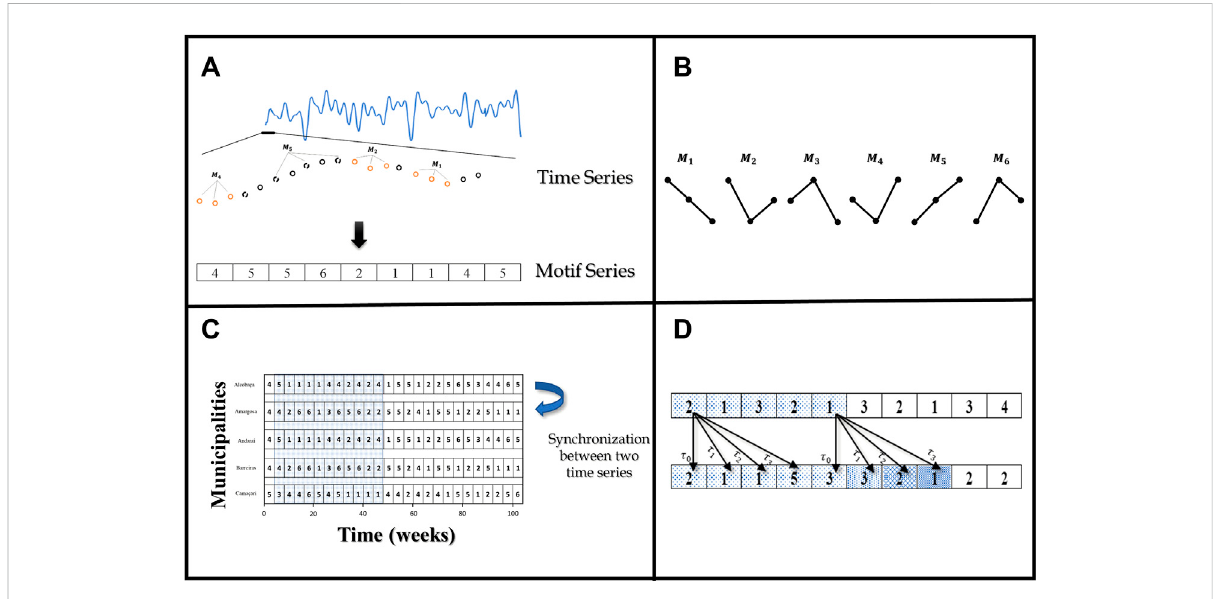
FIGURE 1 (A) Time series being converted into motifs series by mapping a set of three consecutive points of the time series into one of the 6 motifs. (B) Patternsofthe6differentadoptedmotifs,whichdependonlyontherelativepositionsofthepointsinthetimeseries. (C)